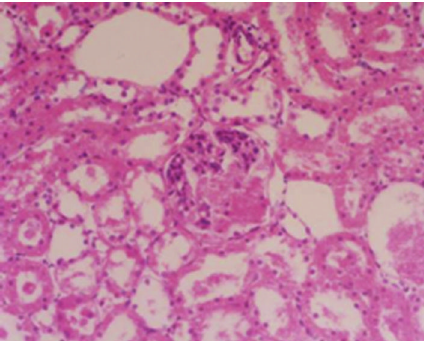
Figure 2: Model-control group 21 days; degeneration and swelling of hepatic cells as well as hyperplasia of bile ducts; HE × 200.